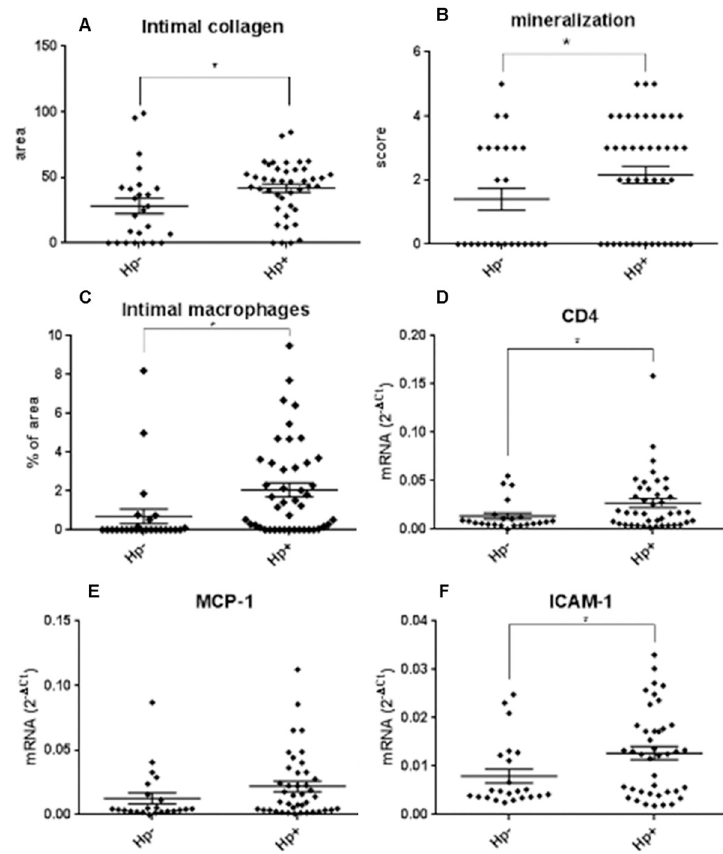
Fig 11. Effect of H . pylori infection on molecular markers of plaque inflammation. Intimal collagen area was determined by computer-assisted image analysis (A, C). Quantitative PCR was carried out using mRNA from intima- media sections of the left common iliac artery (D-F). Data were normalized to the geometric mean of endogenous control genes GAPDH, ACTB, and RPL0. � p < 0.05. (one-sided two-sample T-test) A, n = 67; B and C, n = 69; D-F, n =